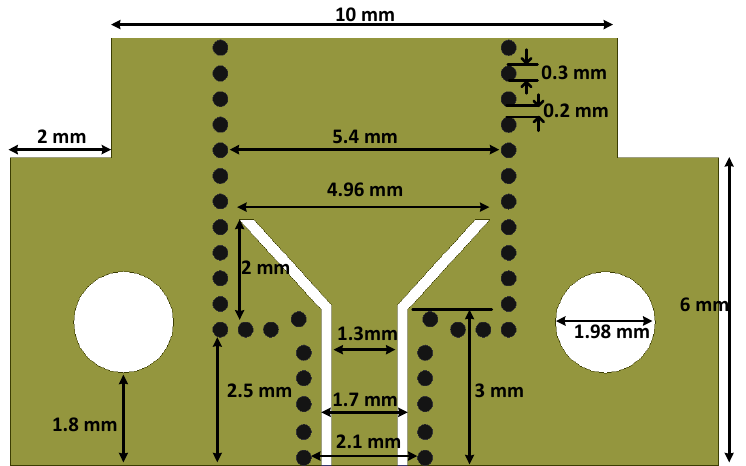
Figure 4. Substrate Integrated Waveguide to the Grounded Co-Planar Waveguide (SIW-to-GCPW) transition.